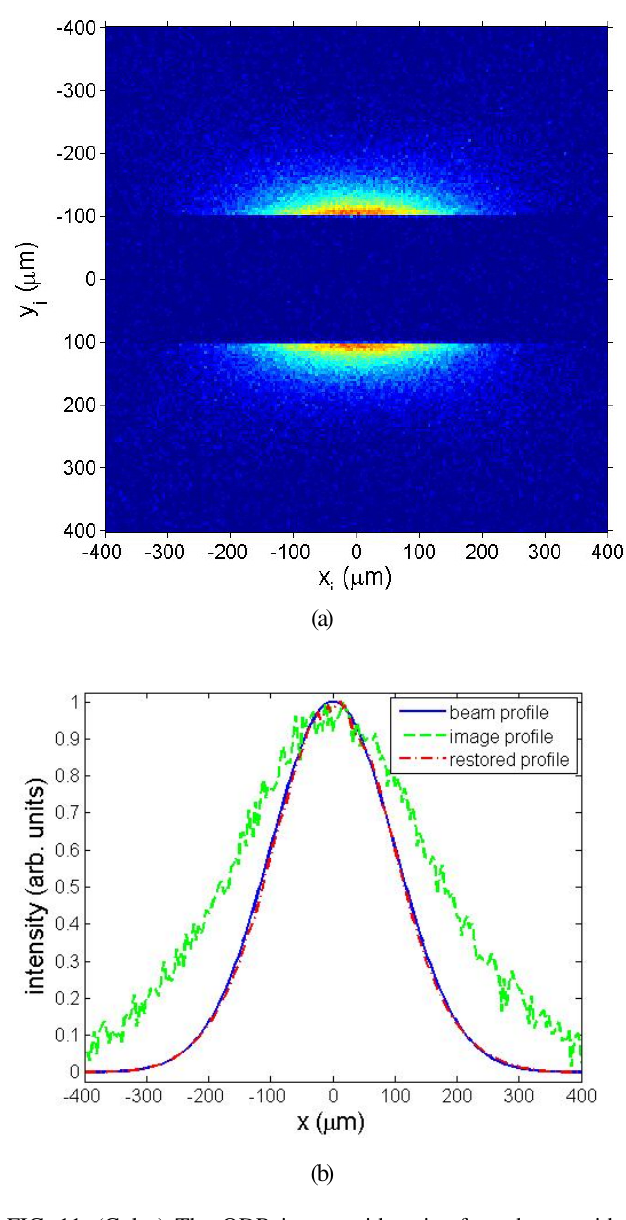
FIG. 11. (Color) The ODR image with noise for a beam with (cid:3) 100 (cid:8) m (a); the projected 1D profile of the beam, the (cid:9) x noisy image, and the restored beam distribution